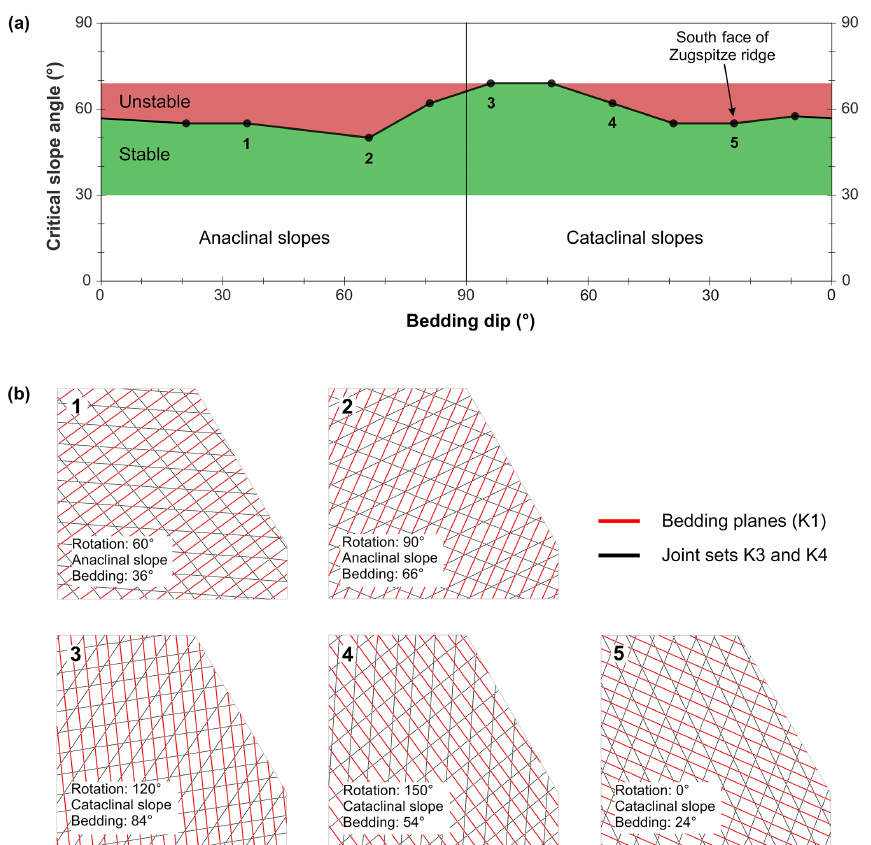
Figure 9. (a) A rule of thumb for critical slope gradients and fracture network orientations of anaclinal and cataclinal permafrost rock slopes. For cataclinal slopes, both the slope face and the bedding have the same dip direction, but for anaclinal slopes, the dips of both are oriented oppositely (Cruden, 2003). The green area refers to stable rock slopes, whereas the red area refers to unstable ones. For simplification, the fracture network is represented by the bedding dip. The coloured areas indicate the studied range of slope angles. (b) Five exemplary joint set constellations for cataclinal and anaclinal slopes with an inclination of 60 ◦ . The numbers of the rock slopes correspond to the numbers in panel (a) . The joint spacing is 10 times bigger than in reality and is only applied for illustration. Example 5 refers to the Zugspitze summit